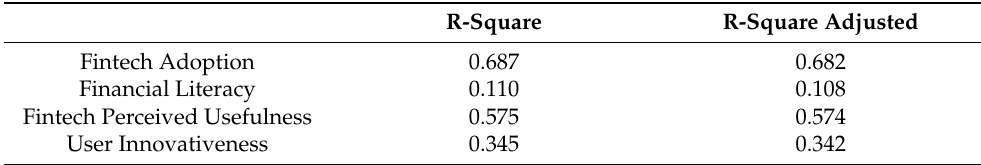
Table 7. Coefficient of determination (R 2 ) values.